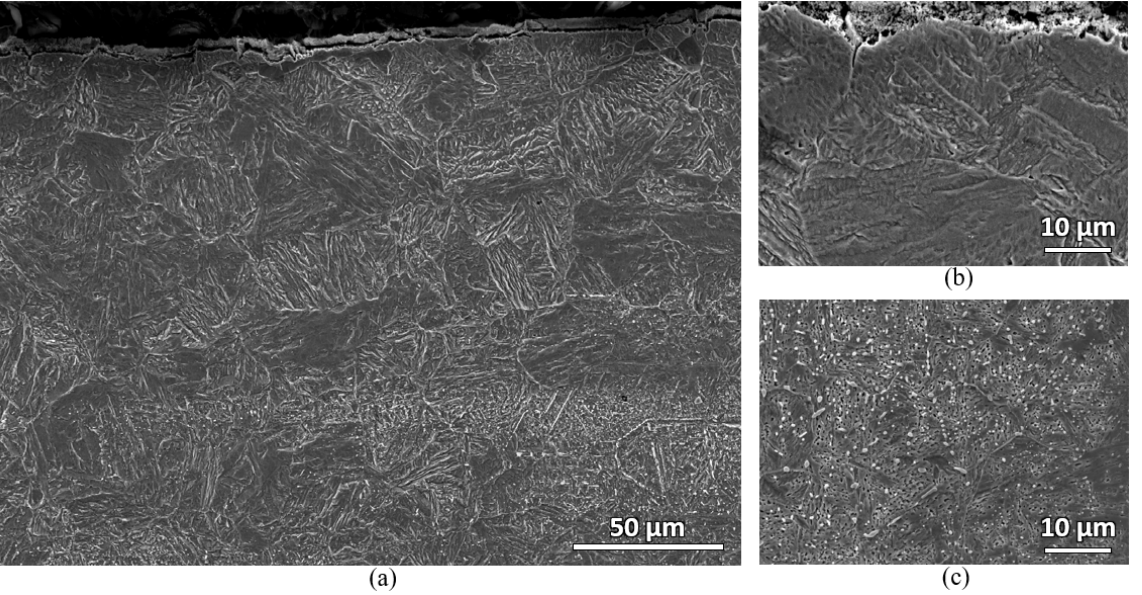
Figure 11. Secondary electron micrographs of the water-quenched furnace-heated sample showing martensitic microstructure with almost no carbide remaining at the near top surface of the sample: ( a ) low magnification near the top surface; ( b ) high magnification near the top surface; ( c ) high magnification at the bulk carbon location of the sample.